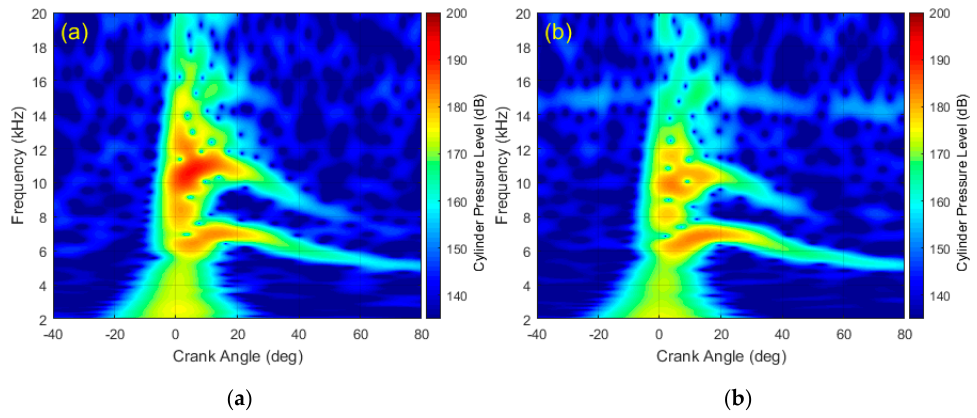
Figure 22. Time-frequency distributions (TFD) of different rail pressure values: ( a ) 960; ( b ) 760 bar.